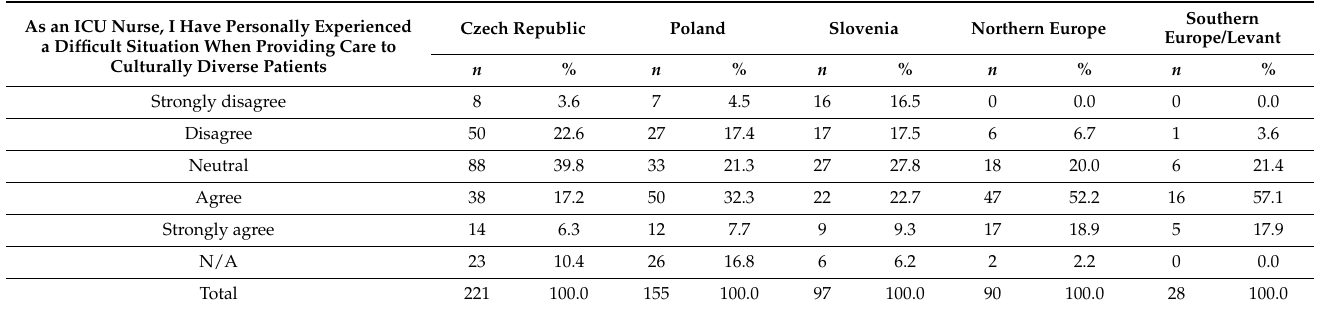
Table 6. Experience of a difficult situation when caring for culturally diverse patients in ICU.